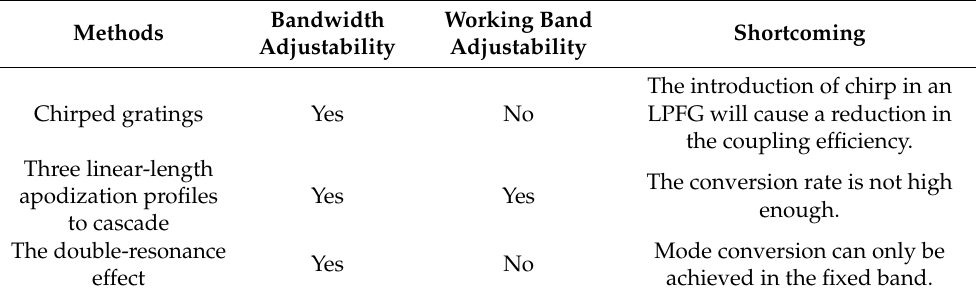
Table 1. The performance difference between the three mode